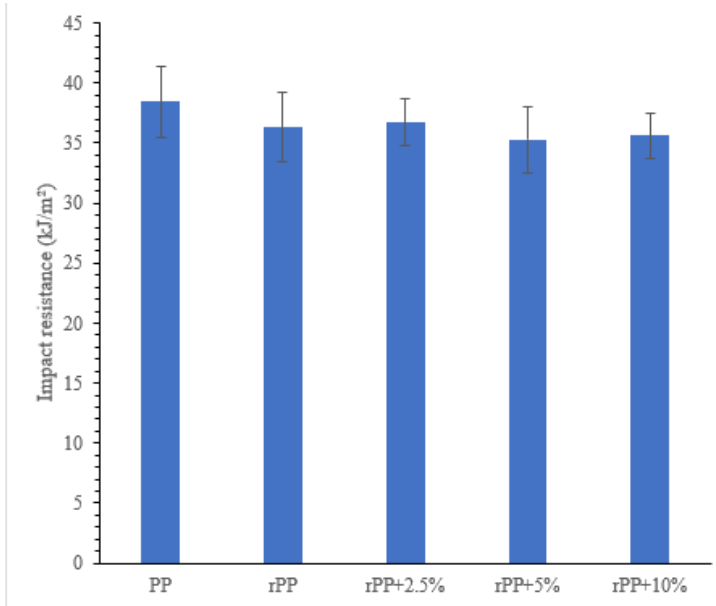
Figure 9. Impact test result.